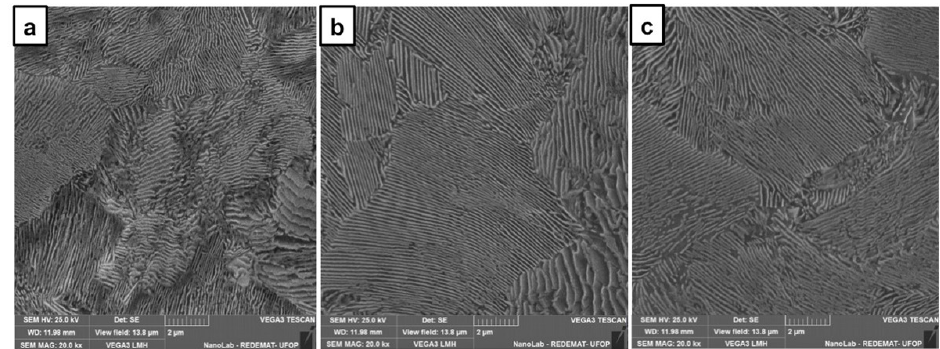
Figure 5. Micrographs of steels A (a), B (b) and C (c) submitted to 0.5 o C/s cooling rate - SEM - 20.000X - 2% Nital etching.